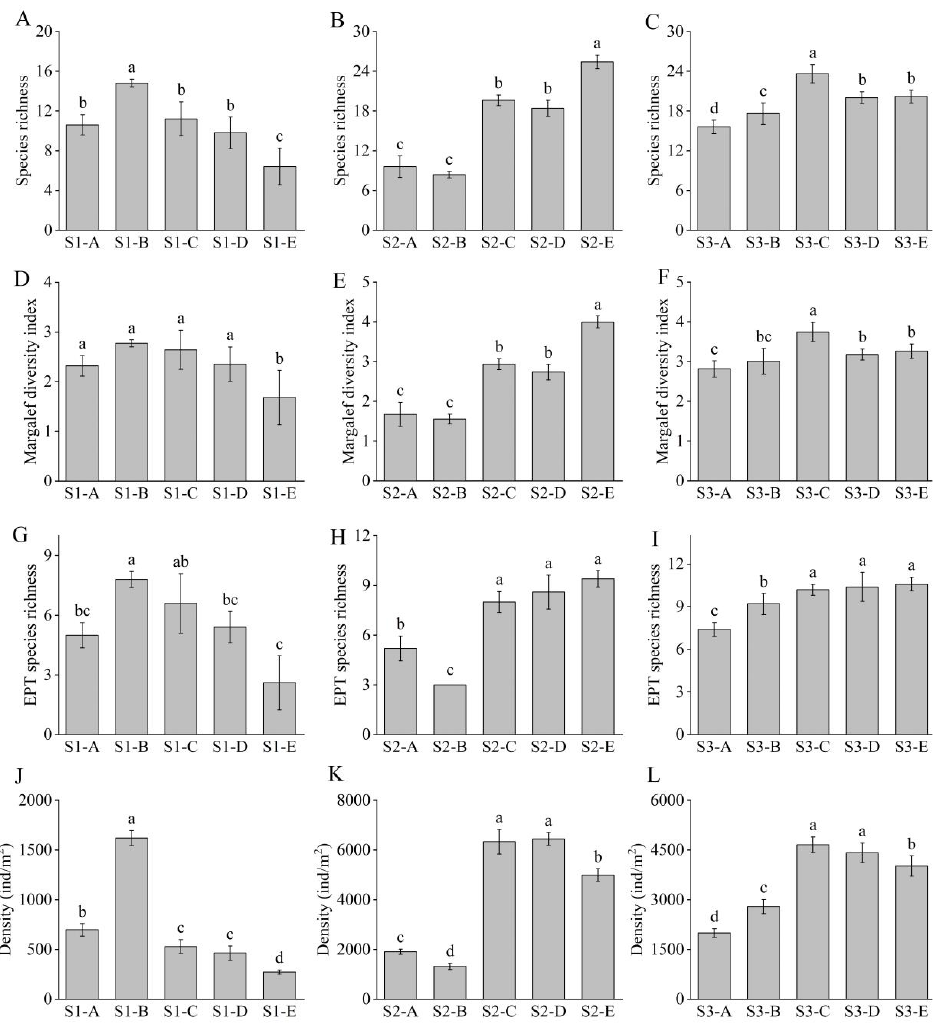
Figure 2. Differences in species richness ( A – C ); Margalef diversity ( D – F ); EPT richness ( G – I ), and density ( J – L ) in S1, S2, and S3 (mean ± SD). S1: Grazing stream; S2: Hot spring stream; S3: Mining stream. The significant differences among each site are indicated by small letters ( p <